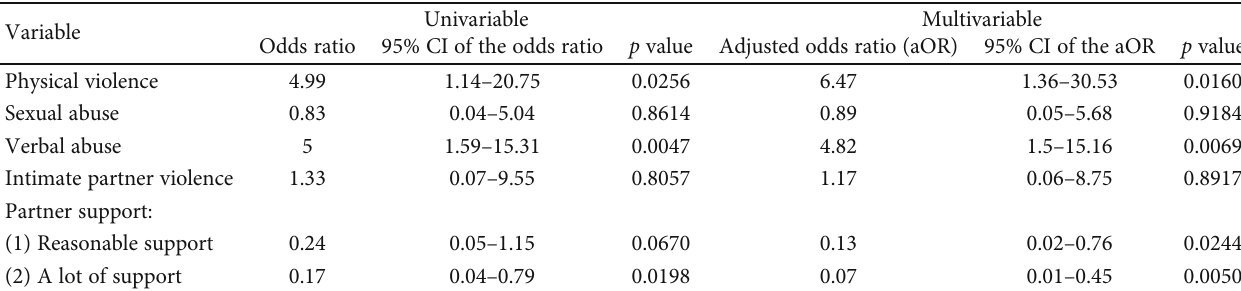
Table 7: Univariable and multivariable logistic regression analysis investigating the in fl uence of selected variables on depression during the antenatal period.